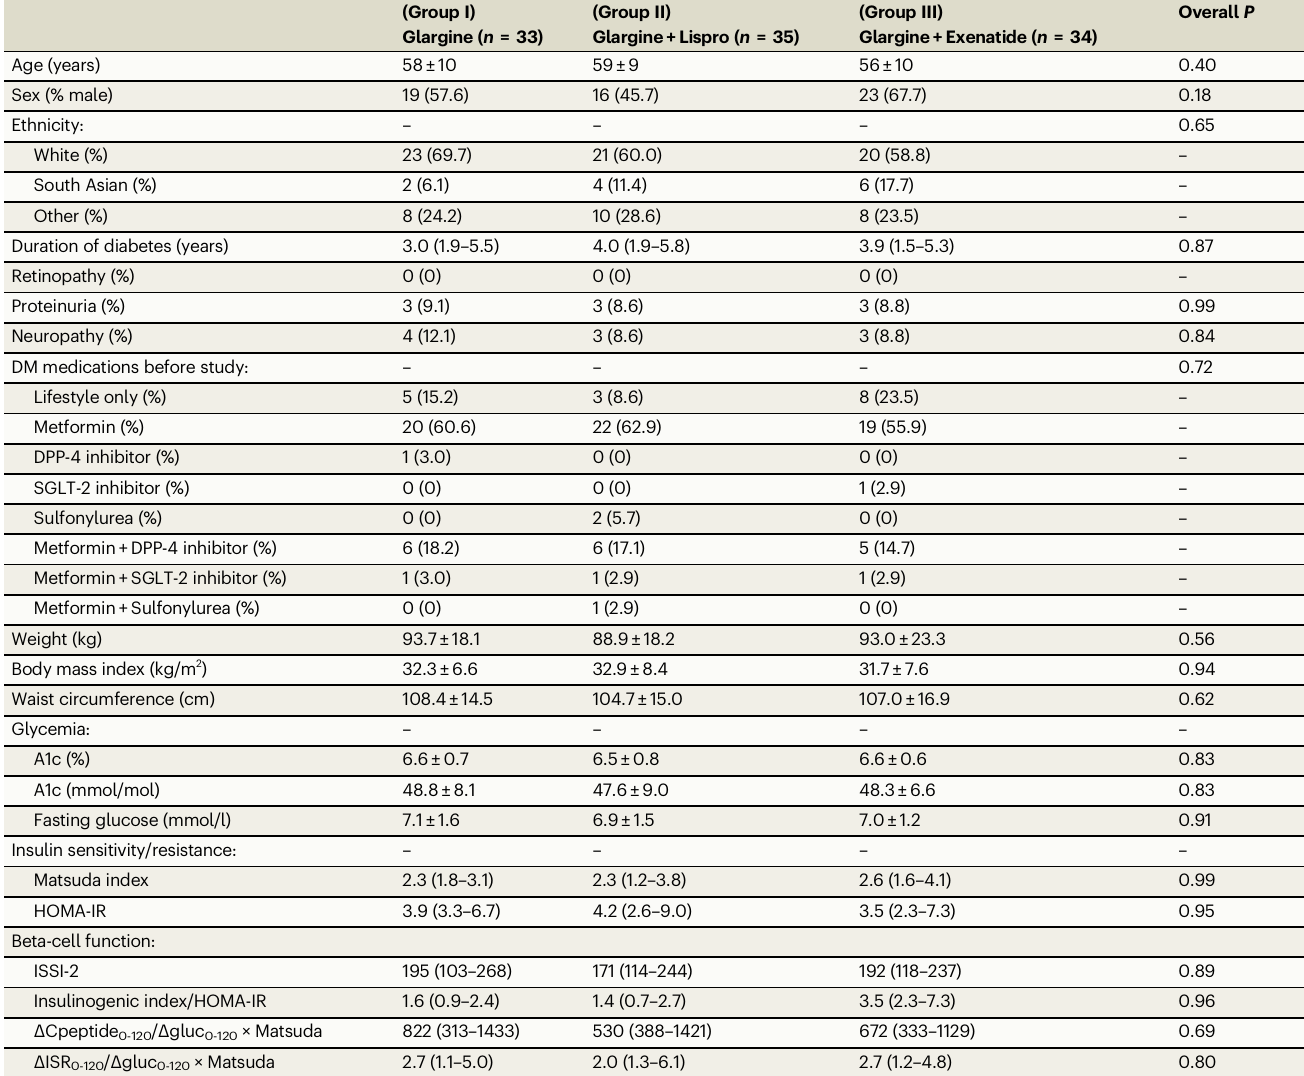
Table 1 | Baseline characteristics of the three groups: (I) Glargine, (II) Glargine + Lispro, and (III) Glargine +